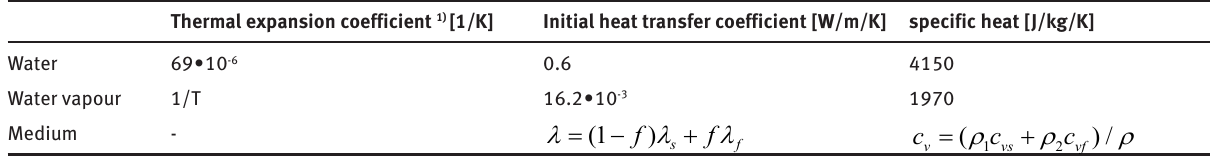
Table 2: Thermal parameters of individual pore fluids and